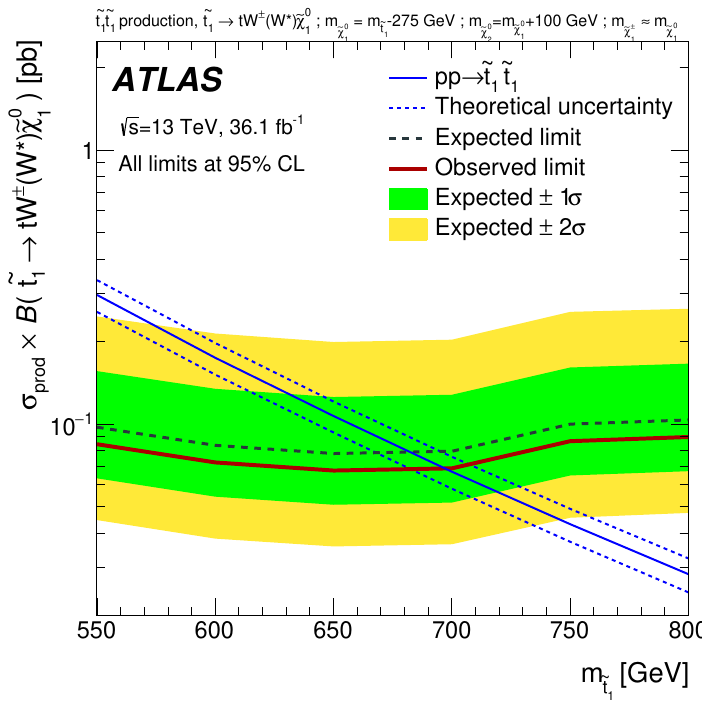
Figure 4e . Observed and expected exclusion limits on the ~ t 1 and ~ (cid:31) 0 RPC SUSY scenario with simpli(cid:12)ed mass spectrum. The signal region used to obtain the limits is Rpc3LSS1b. All limits are computed at 95% CL. The dotted lines around the observed limit illustrate the change in the observed limit as the nominal signal cross-section is scaled up and down by the theoretical uncertainty. The contours of the band around the expected limit are the (cid:6) 1 (cid:27) and (cid:6) 2 (cid:27) results, including all uncertainties except the theoretical uncertainties in the signal